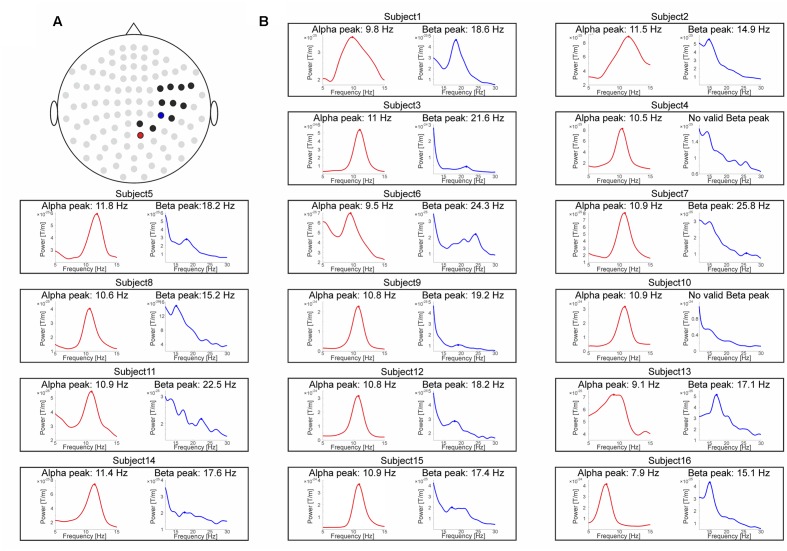
MEG data.
(A) Sensor topography showing the sensors of interest (SOI) selection for the M50 ERF component (0.025–0.075 ms) as black dots. The single channel-pair showing maximum prestimulus (–900 to 0 ms) power levels on group level are marked as red dot for the alpha-band and as blue dot for the beta-band. (B) Spectral power representations for the alpha-band (red, left inset) and the beta-band (blue, right inset) for each subject. The respective peak frequencies are marked by a filled dot and specified above the subject-specific insets.